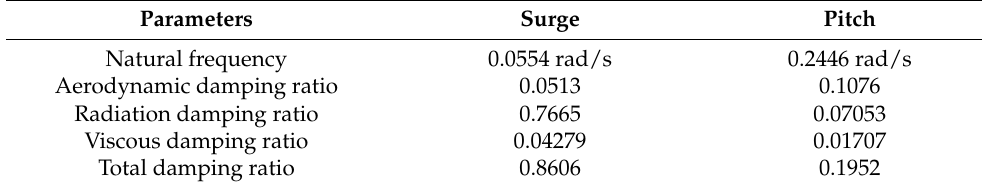
Table 7. Damping parameters of the OC4 platform.